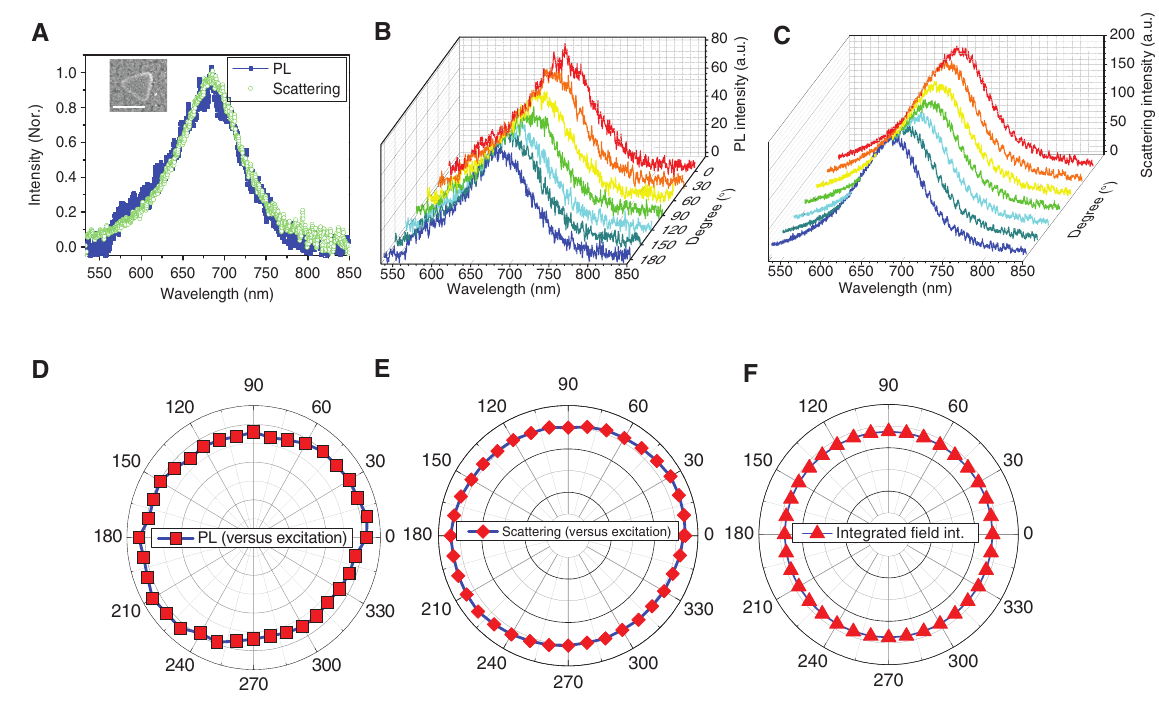
Figure 3: PL and scattering intensity under different excitation polarizations. (A) PL and dark-field scattering spectra for a single Ag TNP, with the SEM image shown in the inset. (B)/(C) PL/scattering spectra under different excitation polarizations. (D)/(E) Polar plot of the measured PL/scattering intensity integrated under the whole spectrum (550– 850 nm) versus the excitation polarization direction varied from 0 ° to 180 ° in steps of 10 ° . (F) Corresponding field intensity | E | 2 integrated over the volume surrounding the TNP (with a thickness of 20 nm as shown in